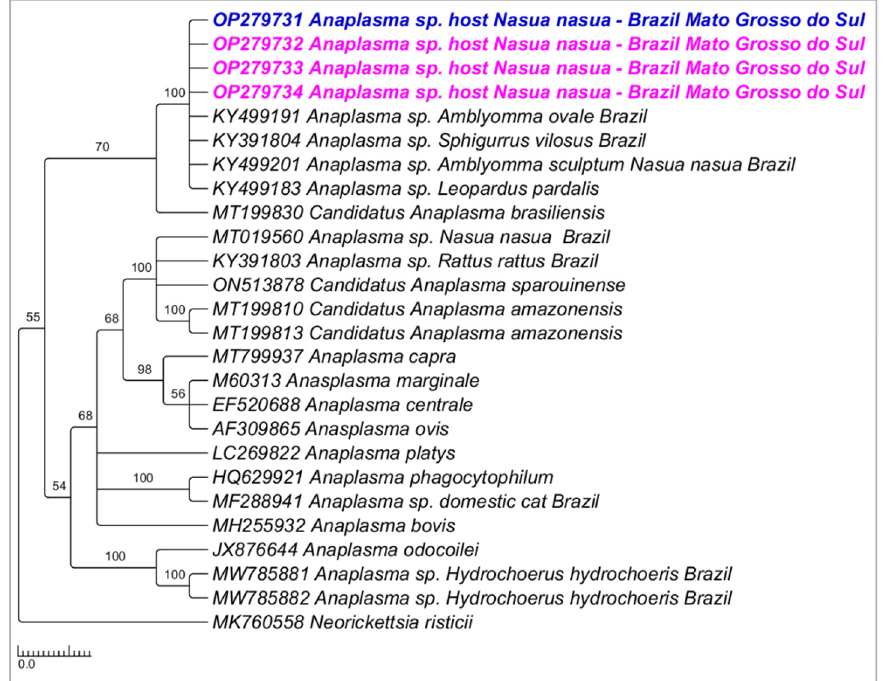
Figure 8. Phylogenetic tree inferred by the Bayesian method and based on the 16S rRNA gene from Anaplasma spp. sequences obtained from blood from ring-tailed coatis ( Nasua nasua ). Sequences detected in the present study are highlighted in bold pink (VBA) and blue (PEP).